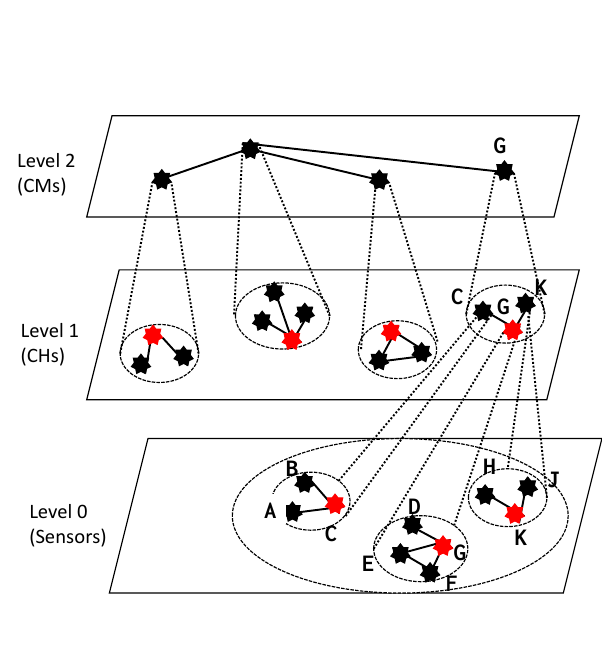
Figure 3. Three level WSN